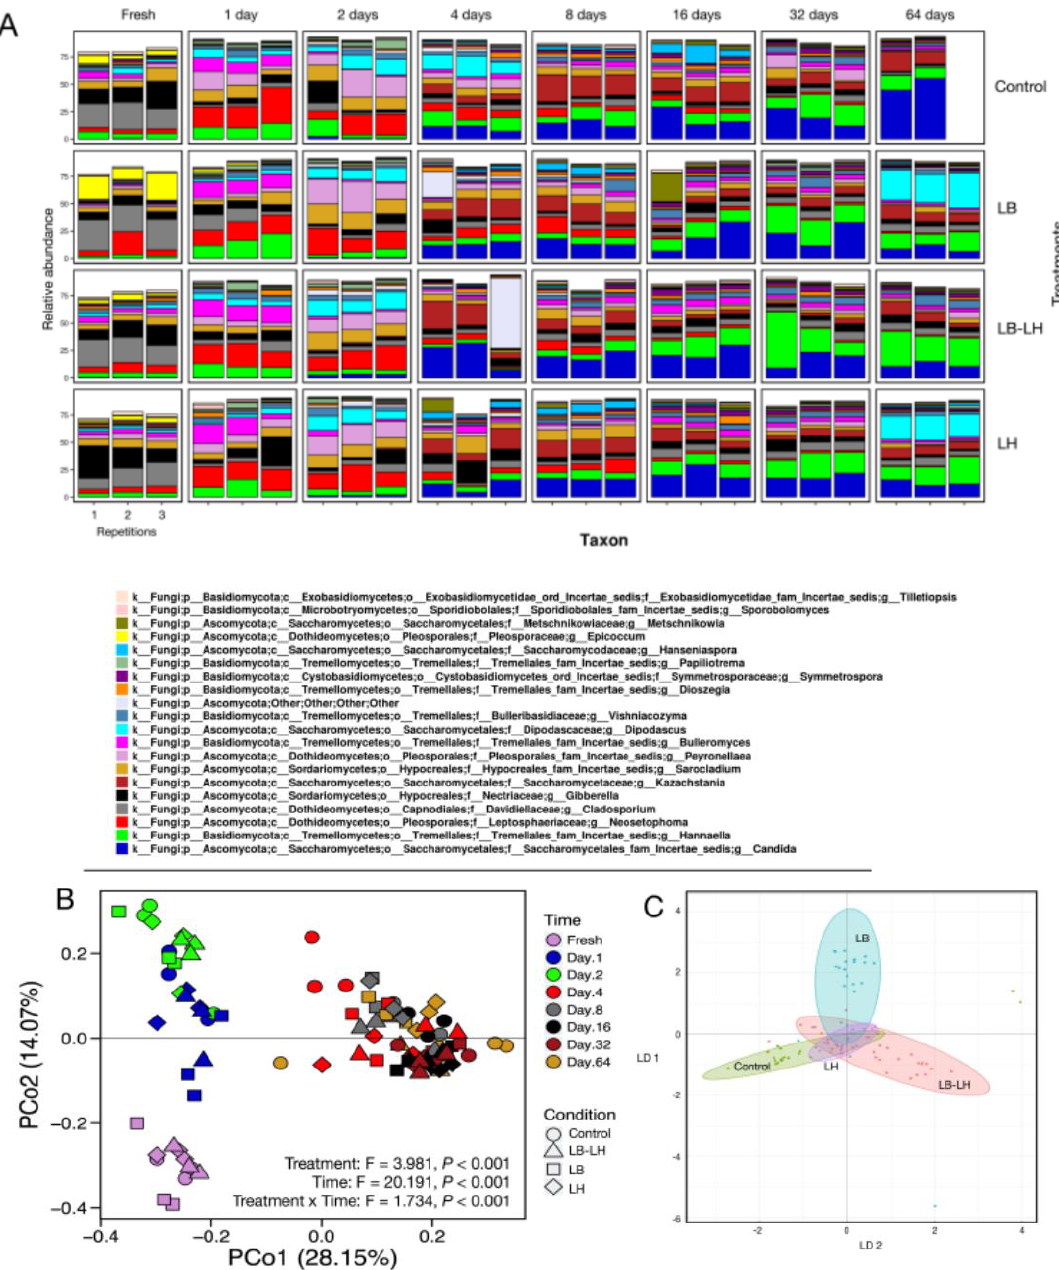
Figure 4. Fungal composition according to ITS amplicon metasequencing (ITS1 region) from corn silages under four inoculation treatments and eight fermentation periods, between fresh and 64 days of ensiling ( A ). Each panel corresponds to a fermentation condition (inoculation treatment × time) and the sequencing results of three independent repetitions. The color coding represents the 20 most abundant taxa, computed using all 32 ensiling conditions. Taxon identification was at the genus level.